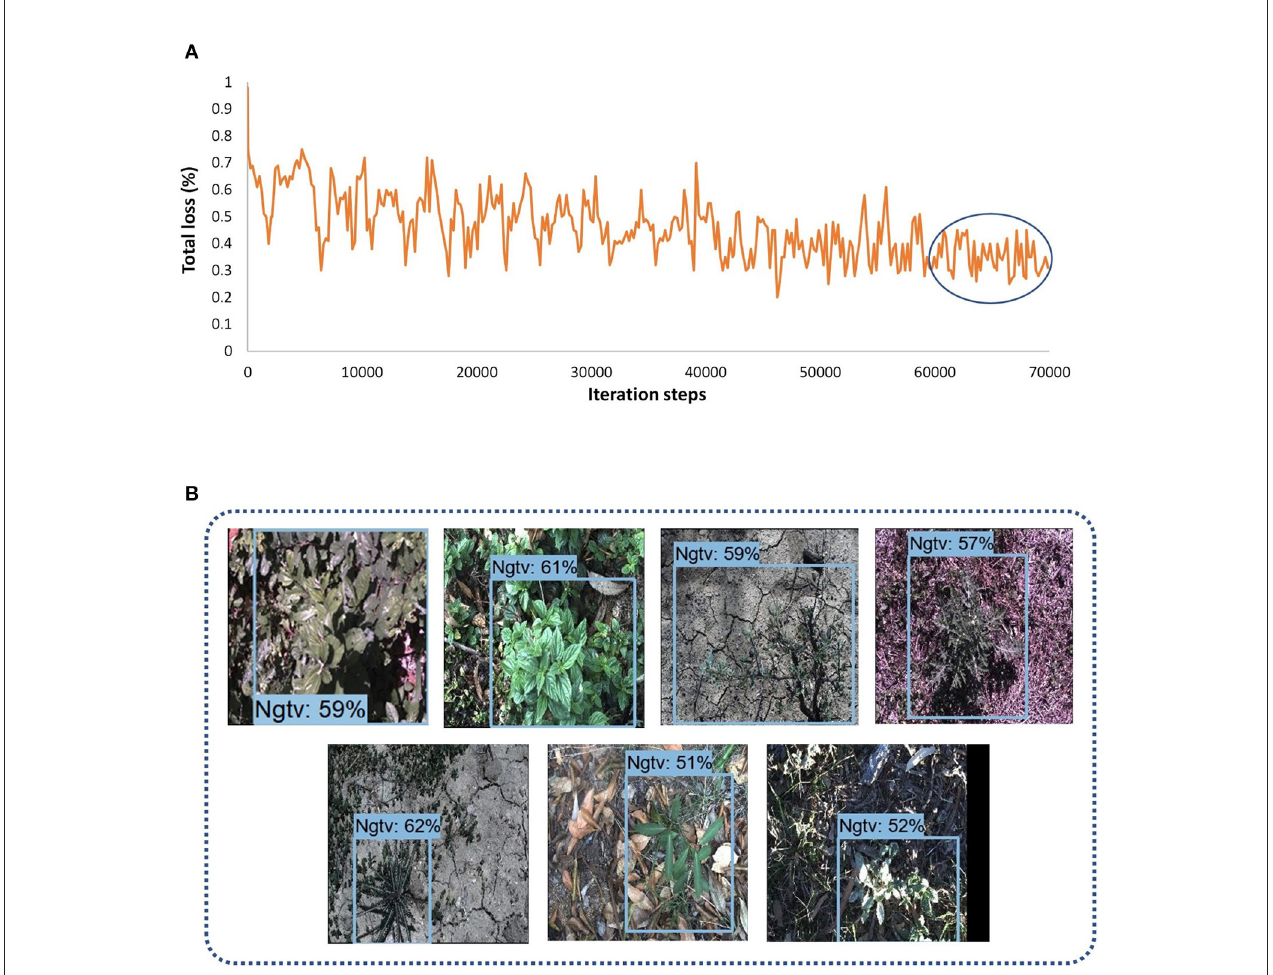
FIGURE 6 | Performance of the EfficientDet model; (A) total loss plots; (B) false positives of different classes with negative